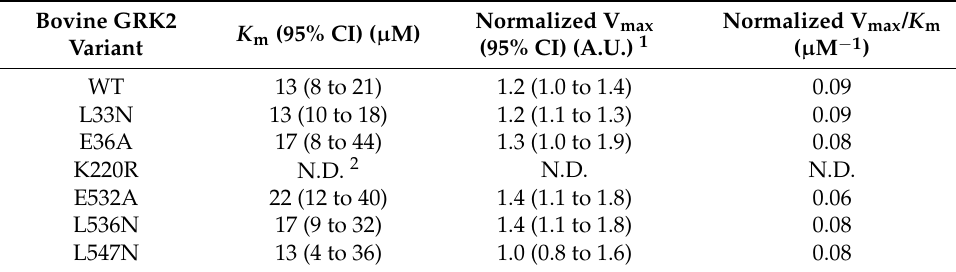
Table 1. Steady-state parameters for tubulin phosphorylation when [ATP] is